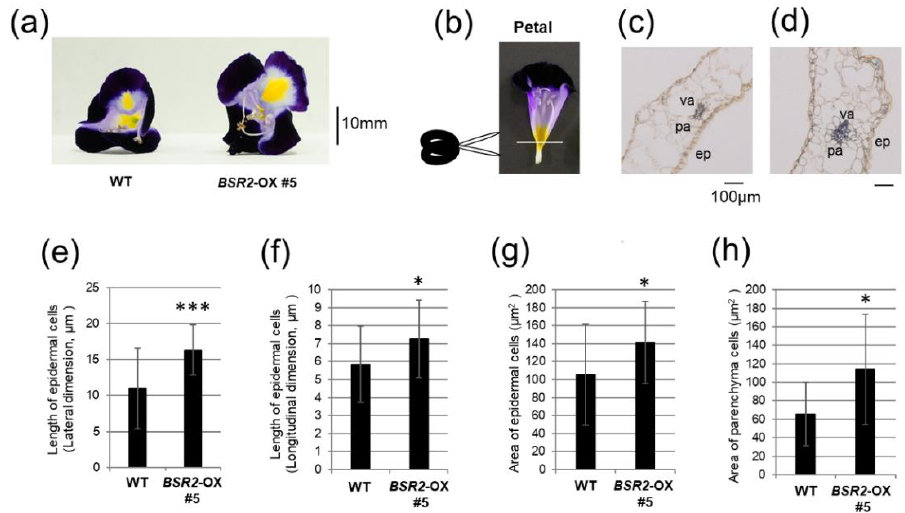
Figure 5. Comparison between the cellular morphology of the petal in WT and BSR2 -OX torenia. ( a ) Comparison of flowers 7 days after flowering. ( b – d ) Cross-section of the basal part of ( c ) WT and ( d ) BSR2 -OX#5 petal. ep, epidermal cell; pa, parenchyma cell; va, vascular cell. ( e ) Lateral and ( f ) longitudinal dimensions of WT and BSR2 -OX epidermal cells in the basal part of the petal. Area of ( g ) epidermal cells and ( h ) parenchyma cells adjacent to the vascular cells in the basal part of the petal in WT and BSR2 -OX. Error bars represent standard deviation. n = ( e ) 19 – 25, ( f ) 21 – 25, ( g ) 19 – 25, and ( h ) 10 – 13. * values significantly different from the WT (* p < 0.05 and *** p < 0.001, t -test).